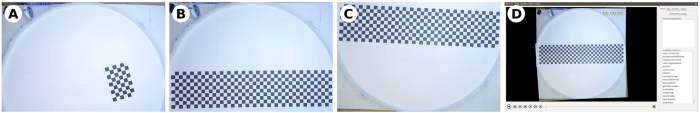
Calibration and stitching of source images to produce a single large resolution image.(A) Each camera is calibrated using a series of images that contain a checkerboard in random positions. (B and C) Top and bottom view of the arena. Both images overlap, and a large checkerboard lies in the overlapping region. The checkerboard is recognized by USE Tracker in both pictures and used to calculate corresponding coordinates. (D) After applying the stitching algorithm, the result is a single, large resolution image of the entire arena.